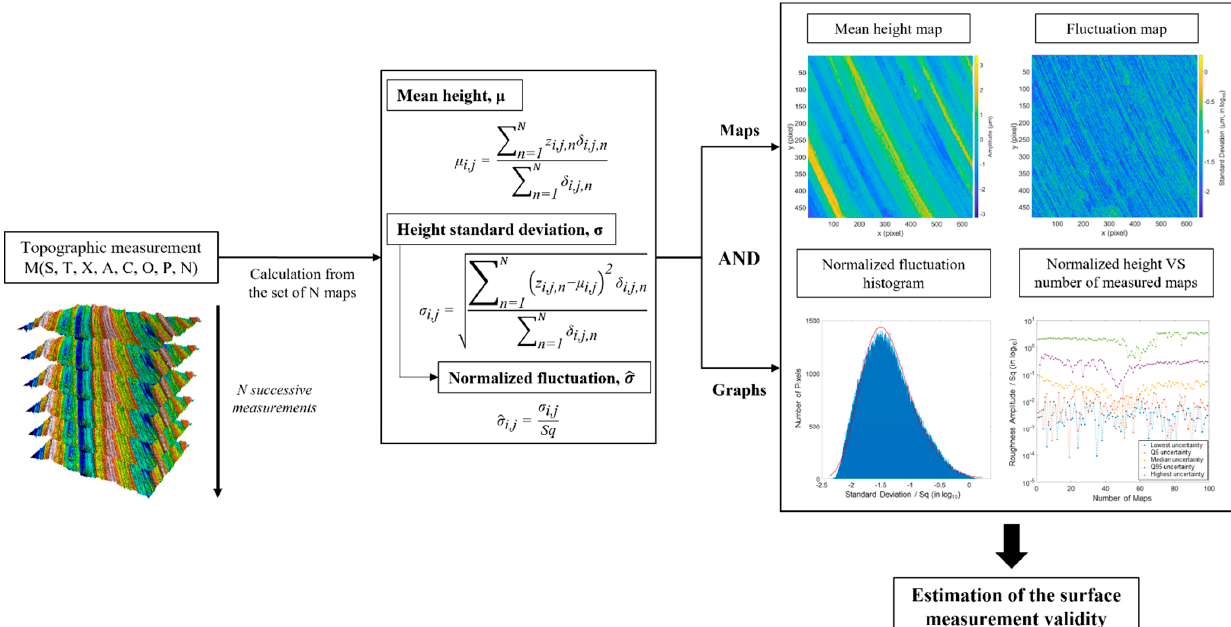
Figure 4. Organigram of the methodology.